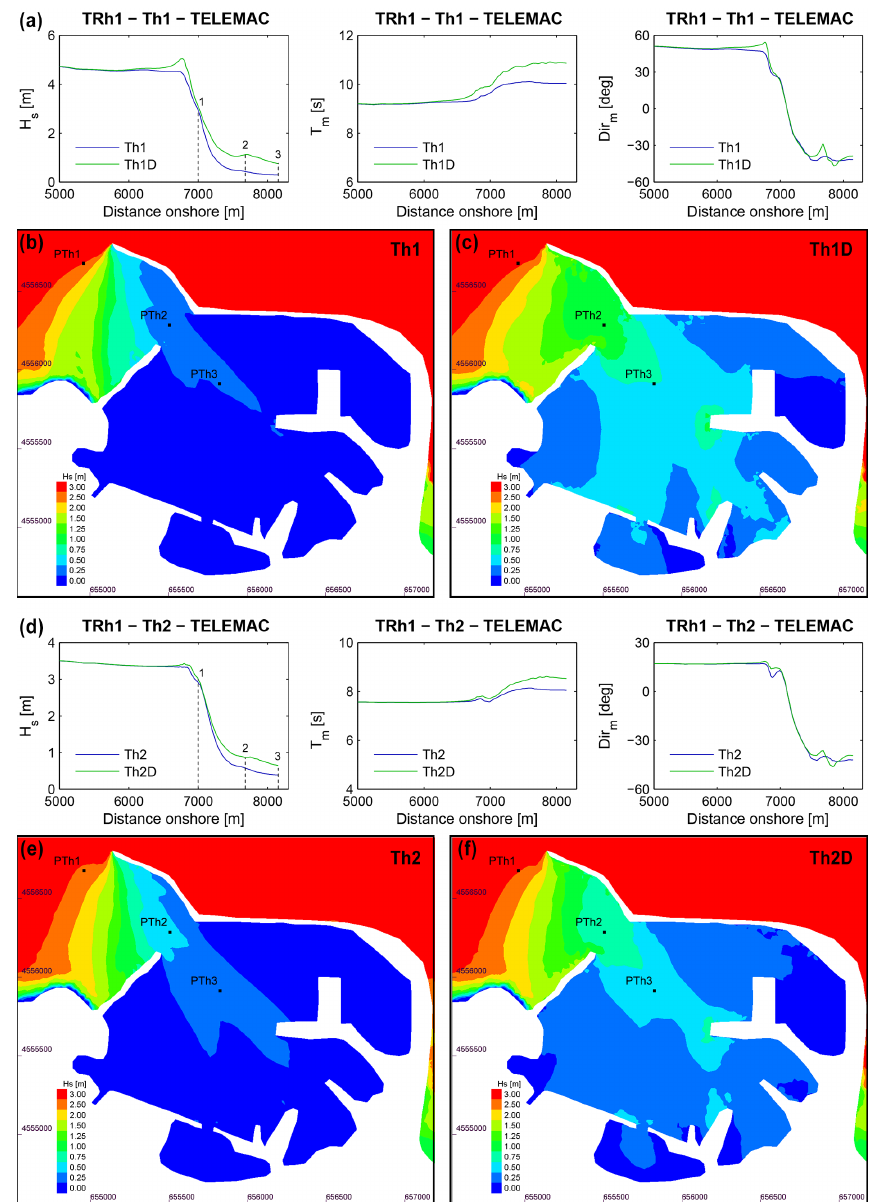
Figure 13. Comparison of TOMAWAC results for the Bari case study: (a, d) along transect TRh1 for forcings WE1 and WE2 respectively; (b, c) and (e, f) as wave fields at the harbour of Bari for forcings WE1 and WE2